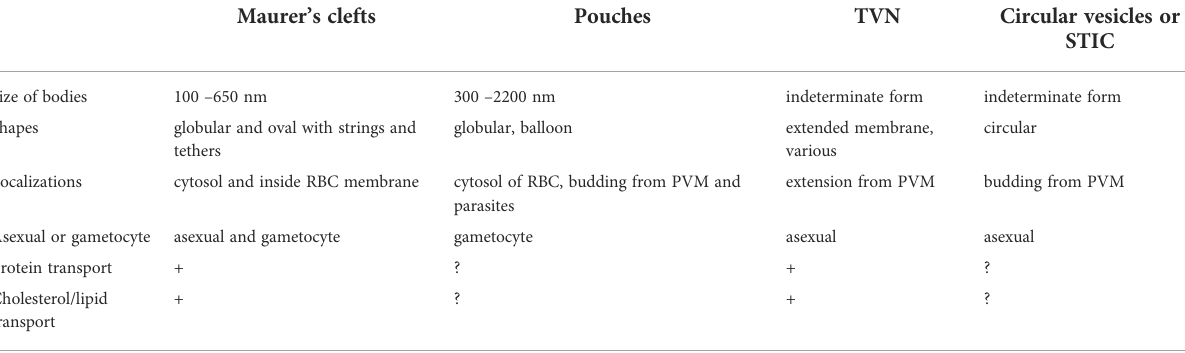
TABLE 1 Summary description of “ pouches ” and other structures in RBCs infected with P.